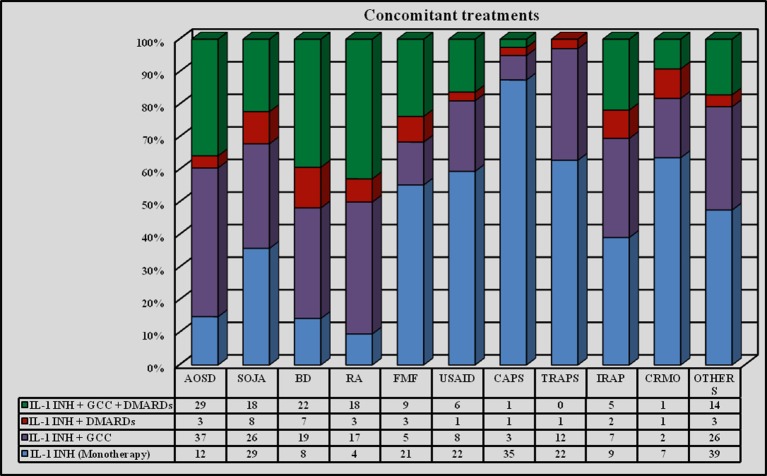
Use of concomitant therapies during IL-1 inhibition distinguishing by different indications. AOSD, Adult Onset Still's Disease; BD, Behçet's Disease; CAPS, Cryopyrin-Associated Periodic Syndrome; CRMO, Chronic Recurrent Multifocal Osteomyelitis; FMF, Familial Mediterranean Fever; IRAP, Idiopathic Recurrent Acute Pericarditis; RA, Rheumatoid Arthritis; SOJA, Systemic Onset Juvenile Idiopathic Arthritis; TRAPS, Tumor Necrosis Factor Receptor-Associated Periodic Syndrome; USAID, Undifferentiated Systemic AutoInflammatory Disease.